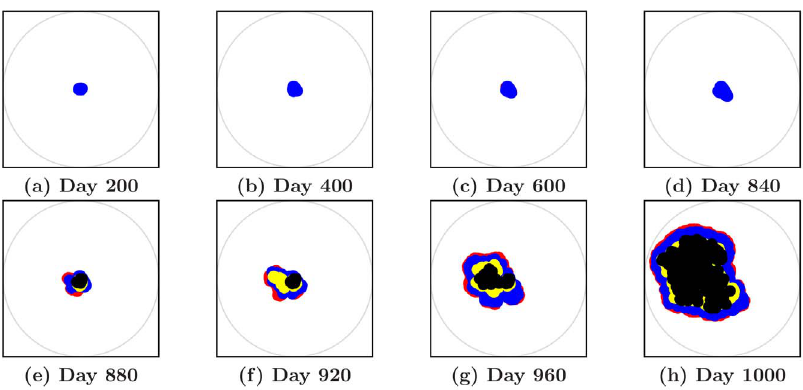
Figure 3. Snapshots of a simulated noninvasive tumor growing in the ECM with (cid:2) rr ECM ~ 0 : 3 on different days given by the CA dormancy model. Upper panel: Dormancy period. Lower panel: Regrowth period.